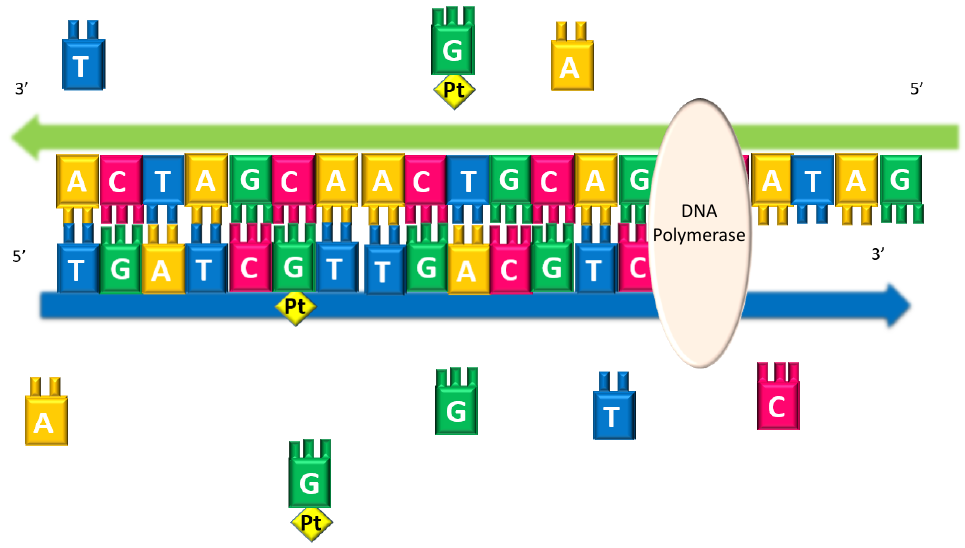
Figure 12. Schematic representation of the insertion mechanism of platinated nucleotides operated by DNA polymerases, during the synthesis of the complementary DNA chain, in the presence of platinated guanines in the nucleotides cellular pool.